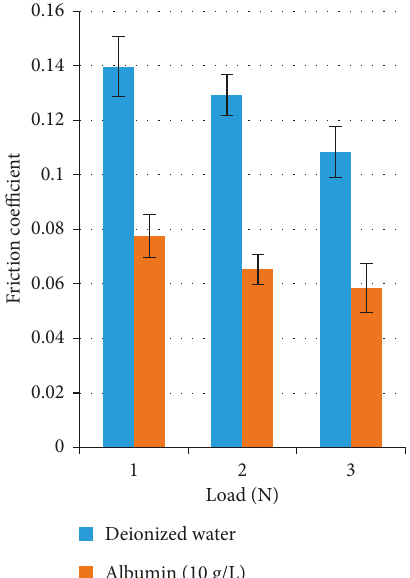
Figure 9: Effect of lubrication condition at a speed of